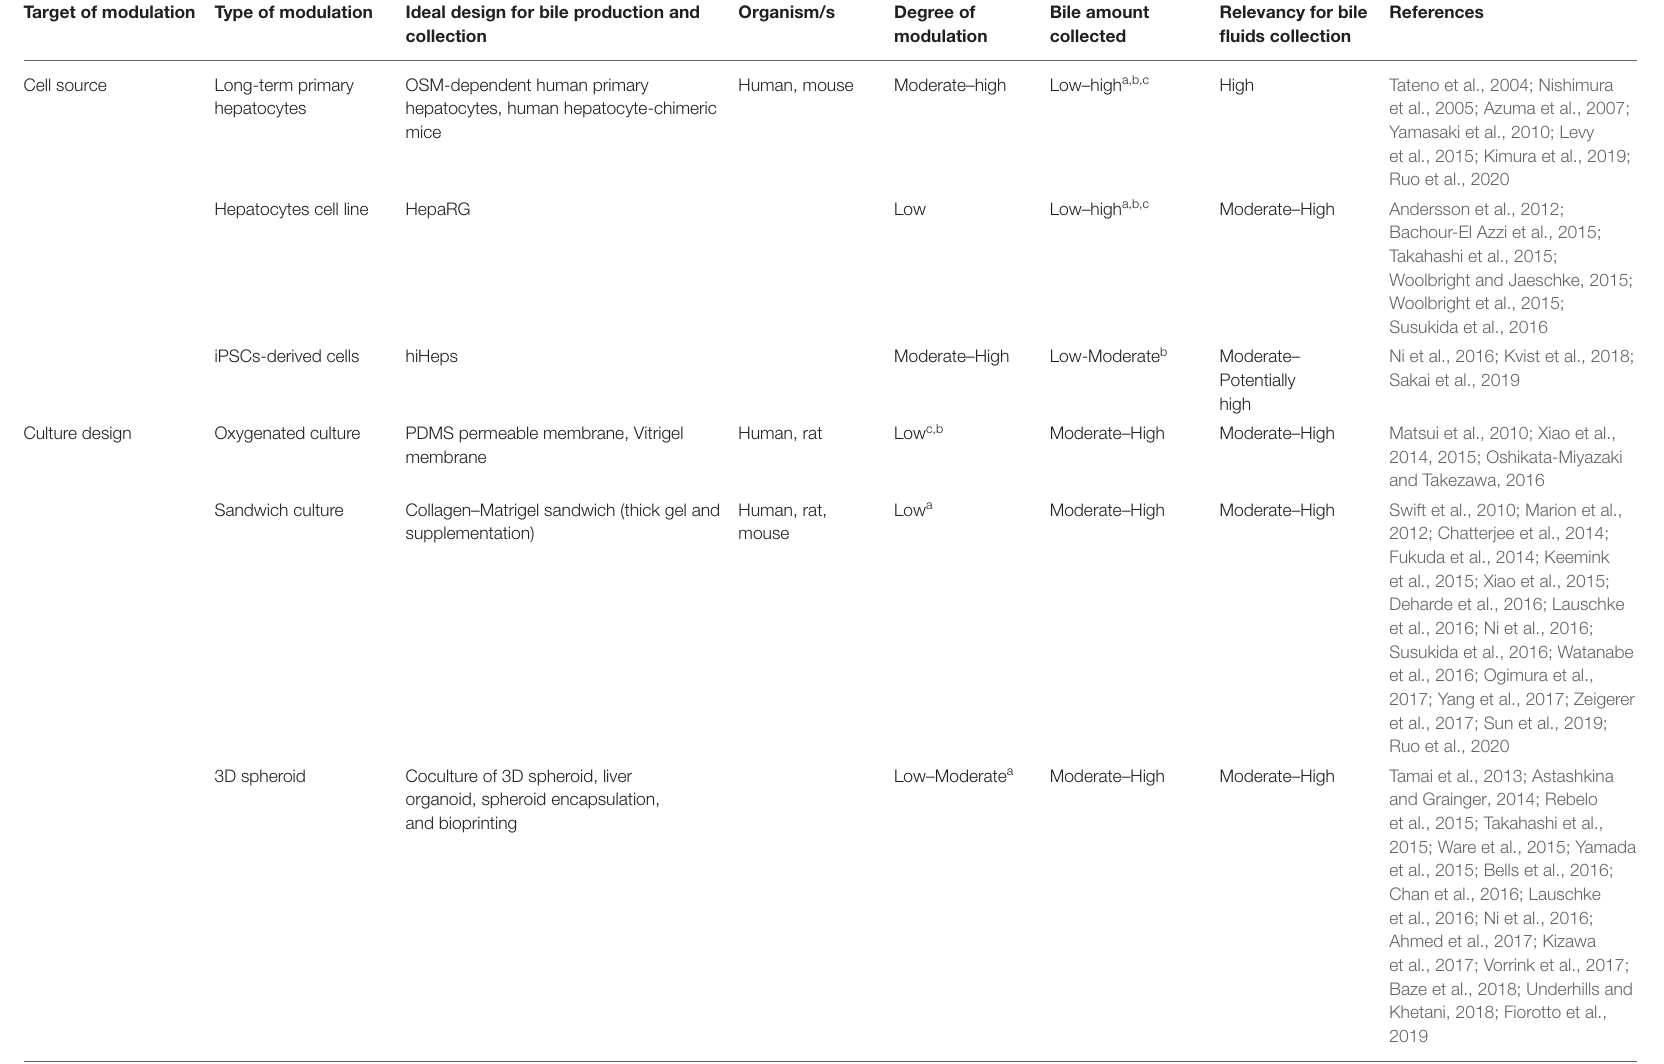
TABLE 1 | Recent studies that significant on the advancement of bile production and collection from liver in vitro